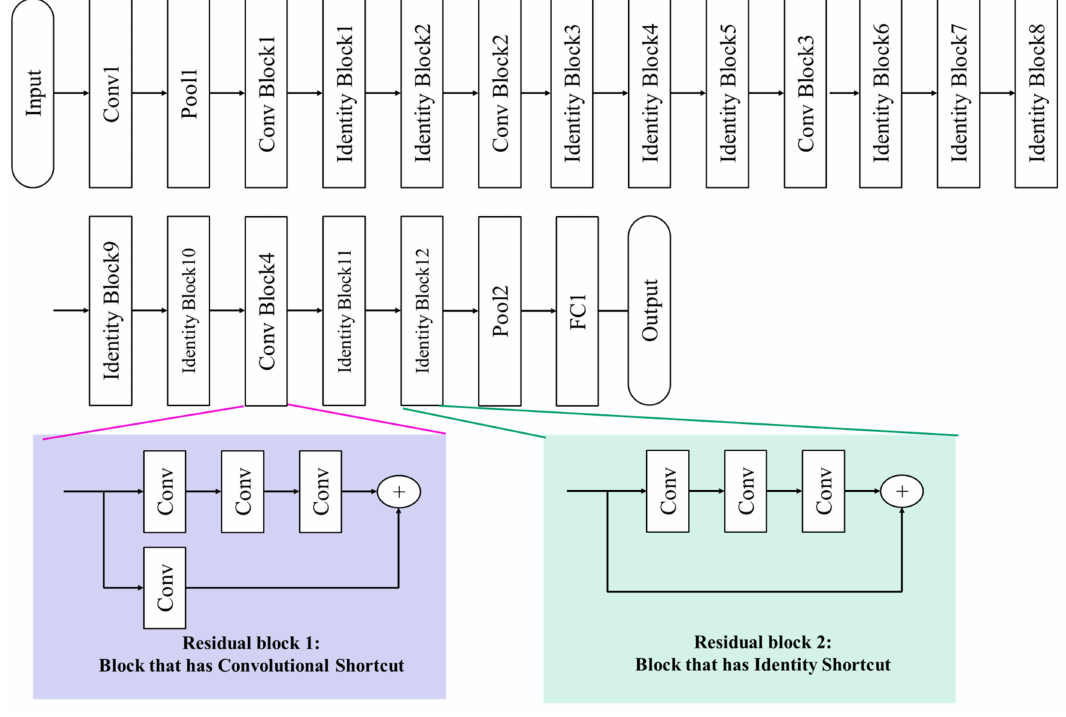
Figure 12. The ResNet architecture